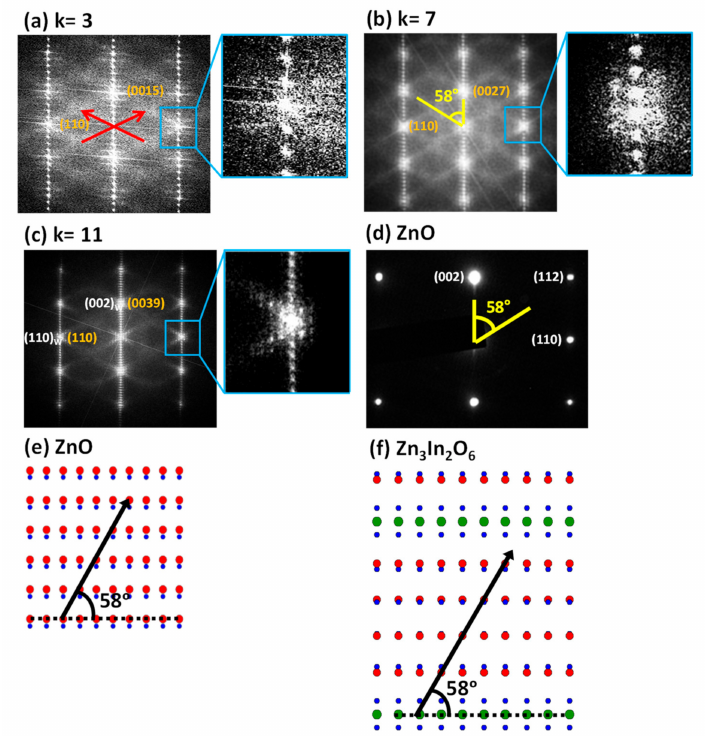
Figure 5. Fourier Transforms of HRTEM images corresponding to the ( a ) k = 3, ( b ) k = 7, and ( c ) k = 11 terms and enlarged area around the (110) reflection as indicated by the blue boxes. In k = 3, the direction of the diffuse lines is indicated with red arrows. In k = 7, the angle between the diffuse lines and the (00 l ) planes, 58 ◦ , is shown. In k = 11, the reflections belonging to the basic substructure (wurtzite) are indicated in white. ( d ) SAED pattern corresponding to ZnO along [110]. ( e ) and ( f ) Representative schemes of ZnO and Zn 3 In 2 O 6 along [11 0]. The arrows indicate the direction of the modulation and the dashed lines the (00 l ) planes. Color code: In (green), Zn (red), O